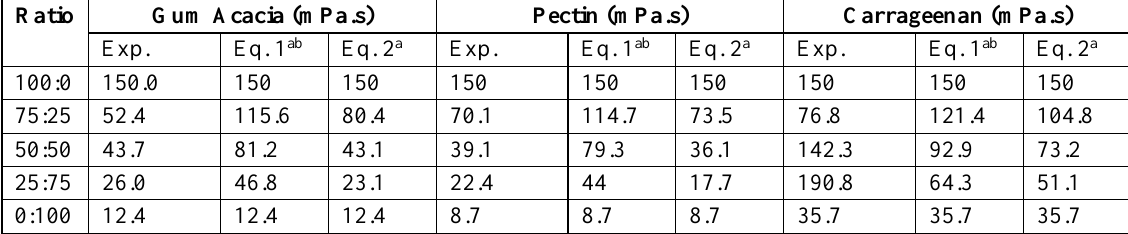
Table 3. Estimation of the apparent viscosity of alginate mixture without CaCl 2 Ratio Gum Acacia (mPa.s) Pectin